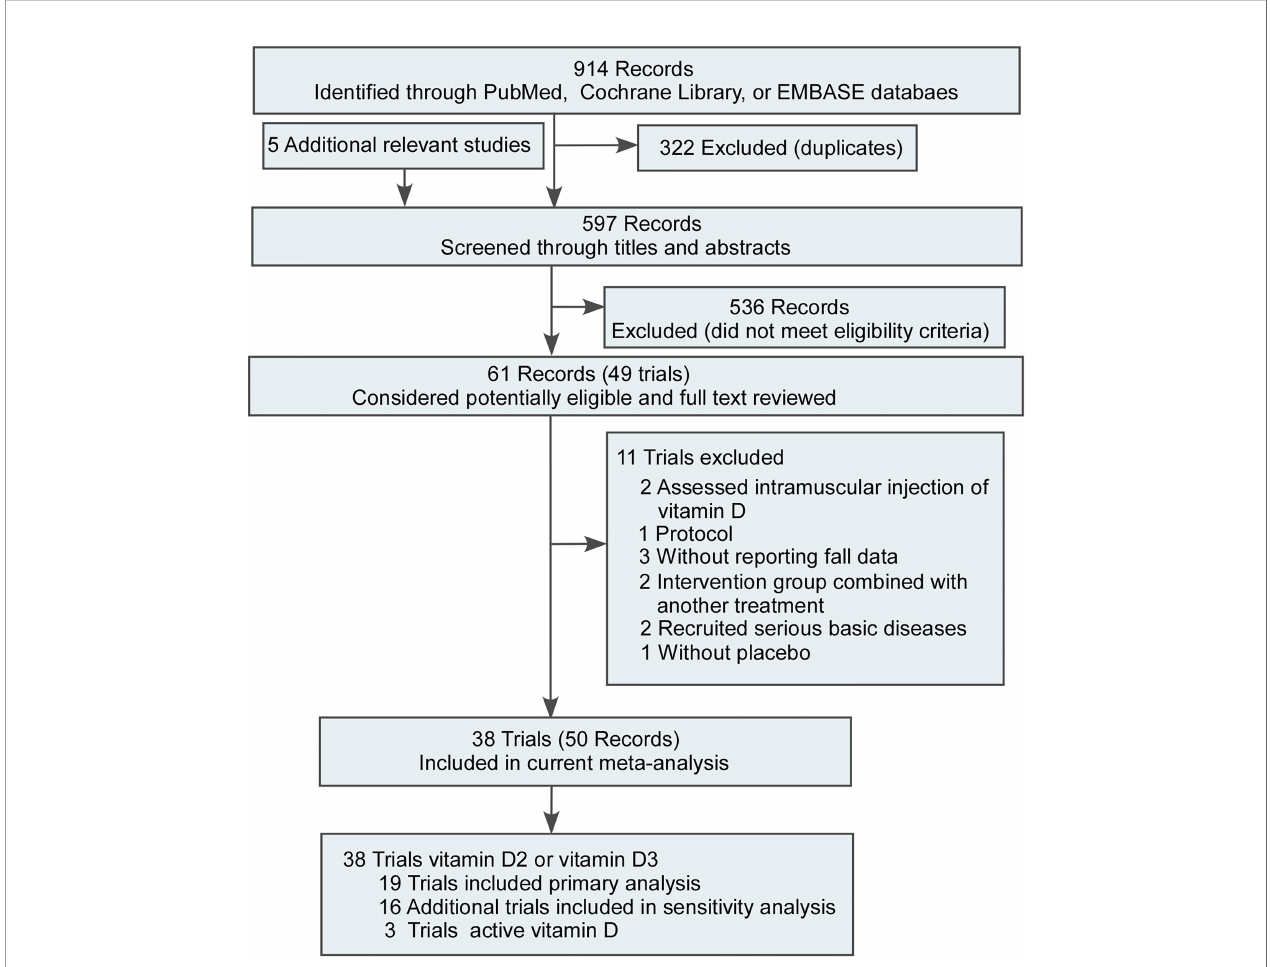
FIGURE 1 | Literature Search and Screening